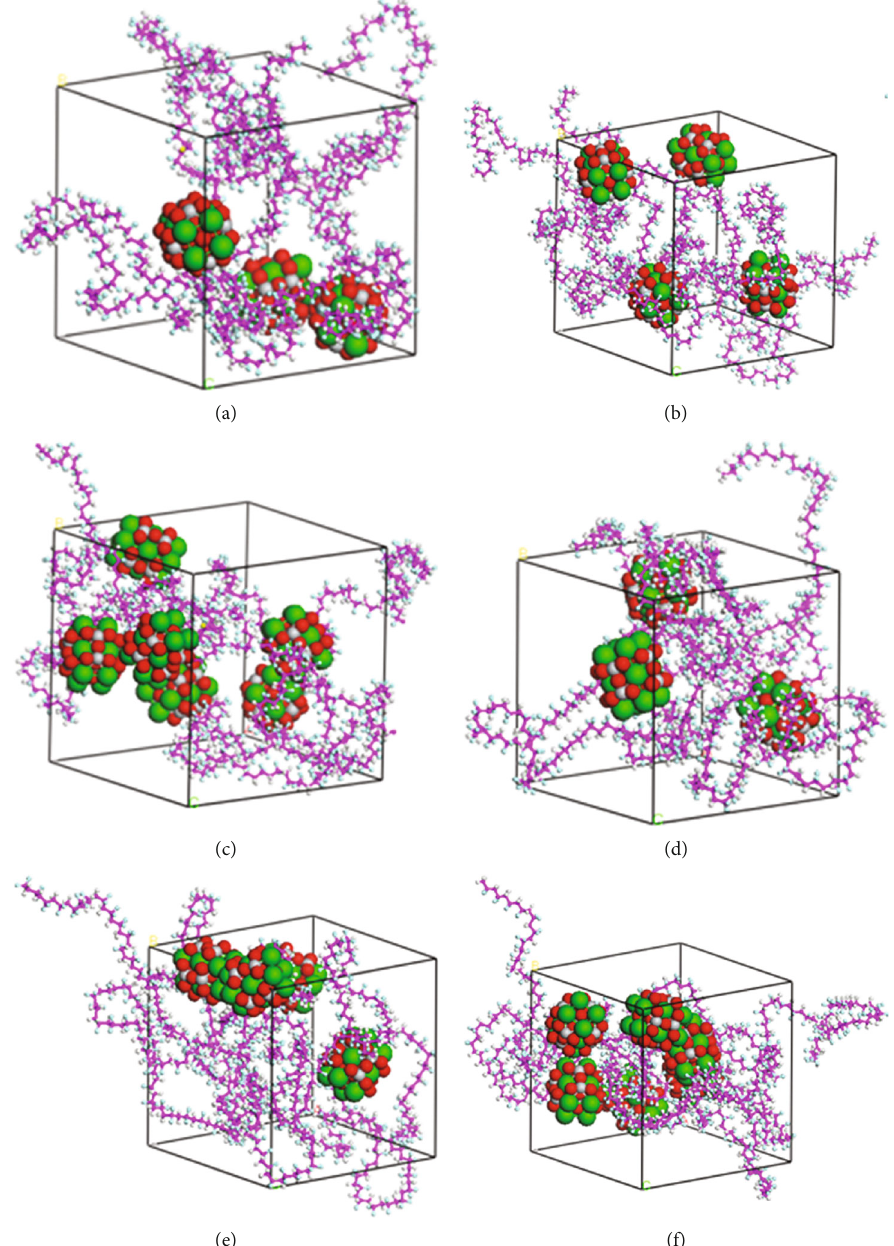
Figure 5: The initial model (a – c) and the simulated structure (d – f) of BT/PVDF composites BT10/PVDF (a, d); BT15/PVDF (b, e); BT20/PVDF (c,